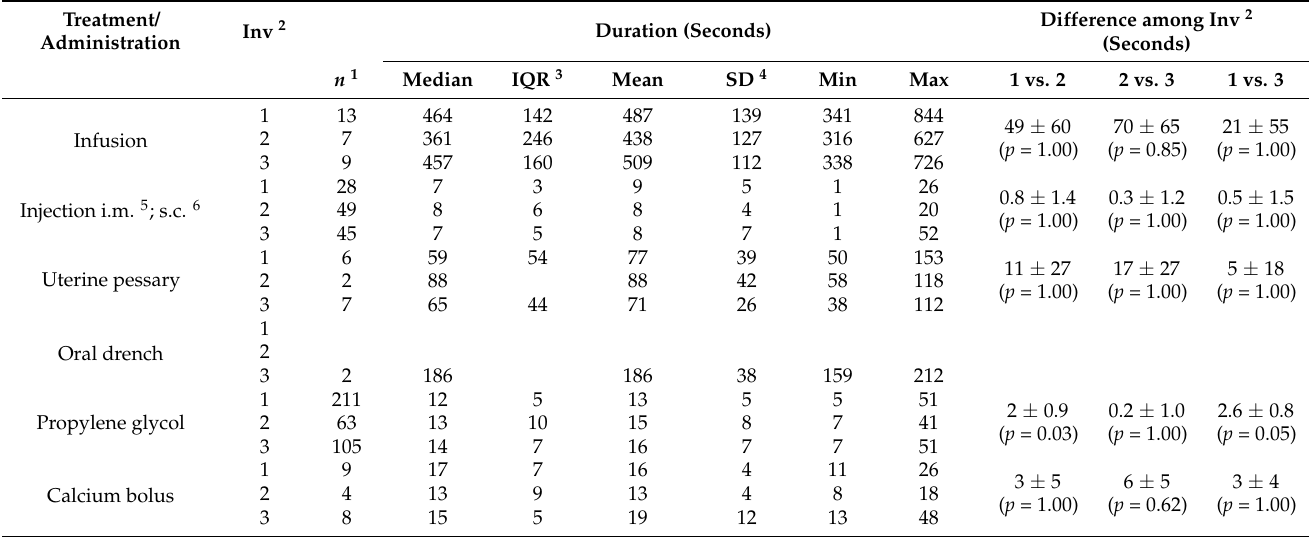
Table 7. Duration of examinations presented for each of the three investigators (Inv) and differences among the investigators (mean ±